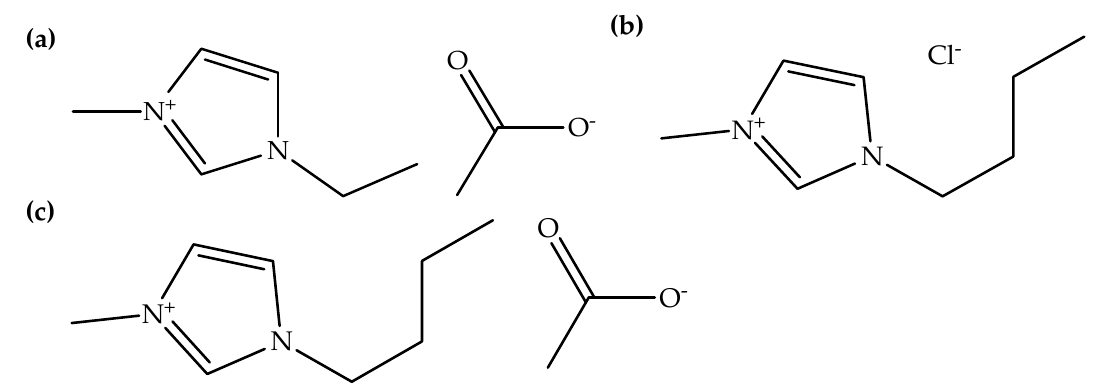
Figure 3. Chemical structures of ( a ) [C 2 mim][OAc], ( b ) [C 4 mim][Cl], and ( c ) [C 4 mim][OAc].